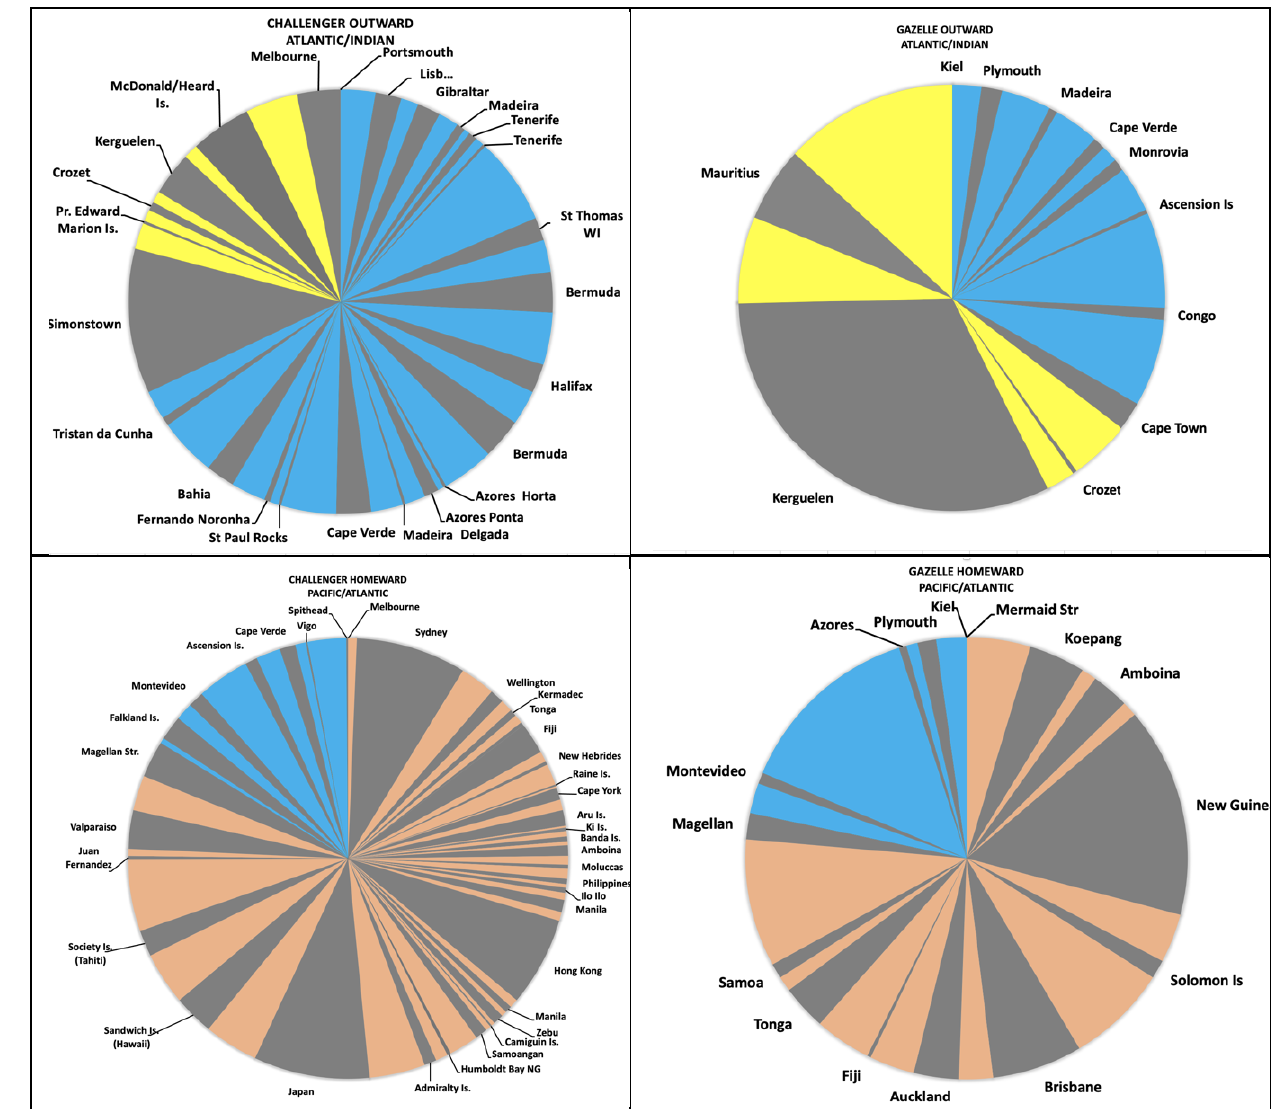
Figure 5. Time spent in ports and periods of extensive surveys (grey colouring, sequence reads clockwise) compared with time at sea (coloured sectors, Atlantic (blue), Indian and Southern (yellow), Pacific (brown)). Format follows that used by Aitken and Foulc (2019). Dates in port are in Table